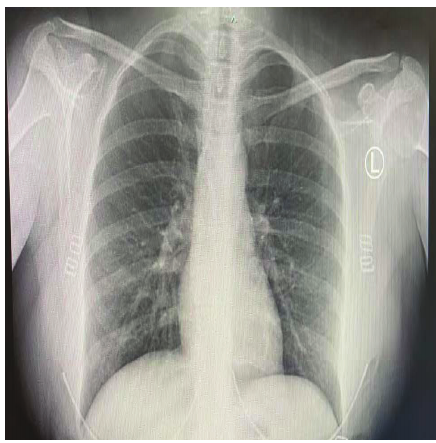
Figure 4. Normal